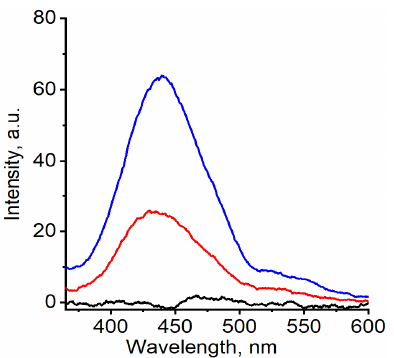
Figure 8. Fluorescence ( λ ex = 312 nm) spectral patterns of the aqueous solution of TPA (black) forming TPA-OH after irradiation with visible light at 15 min in the presence of GO/Zn (OAc) 2 /glu-PDI (blue) and GO/Zn (OAc) 2 /PA-PDI (red).